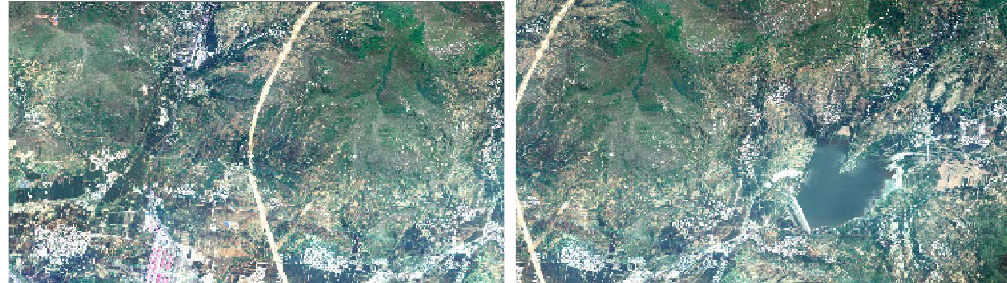
Figure 5. Overlapped images with identified corresponding point